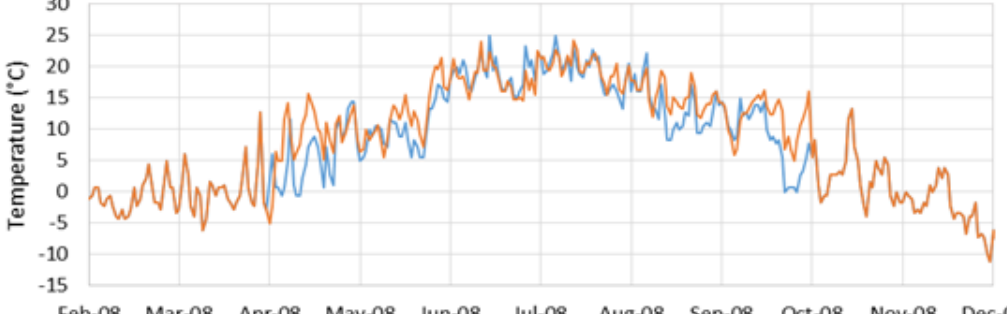
Figure 6. Results from the first realization of data imputation over a 180-day (6 month) gap. This longer gap shows an annual temperature rise from the spring through the fall, April through September. The imputed data match the observed signal well, not only recreating this annual change but doing a good job of matching short-term fluctuations, on the order of a few days.